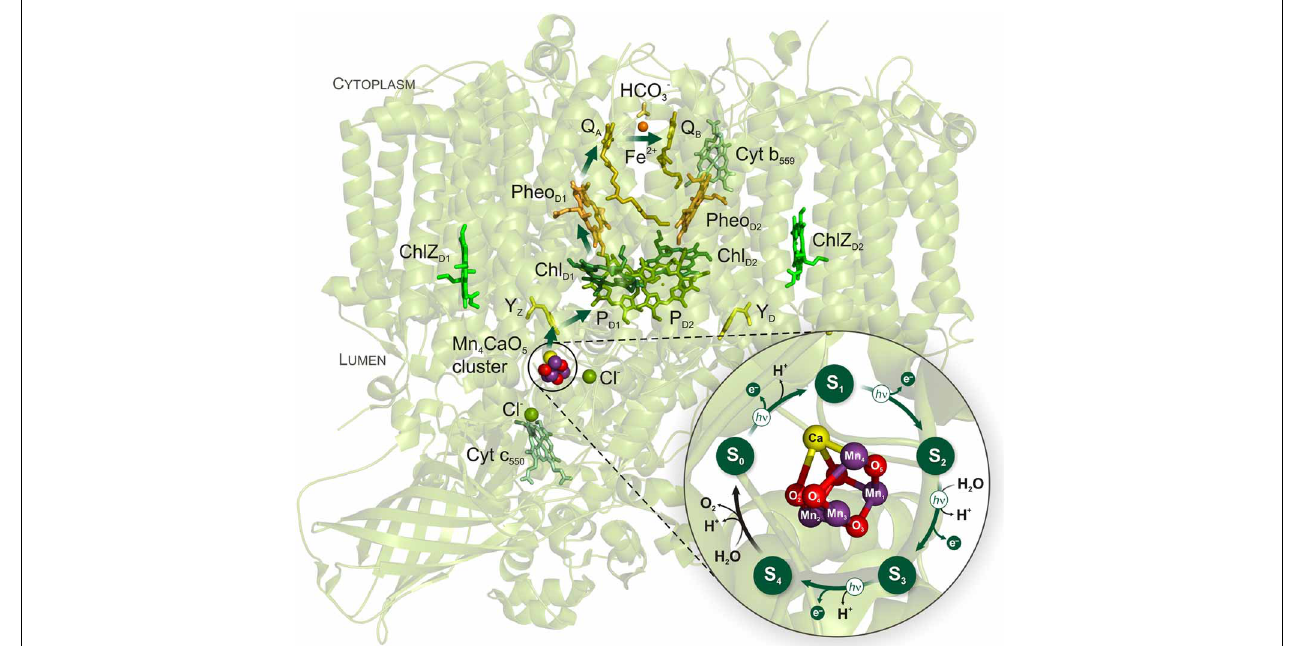
(Q B ) quinone acceptors. The phytyl tails of the Chl’s and Pheo’s, and the isoprenyl chains of the quinones have been cut for clarity. The light-induced S state transitions of the Mn 4 CaO 5 cluster are indicated by arrows with “ h ν ” labels. The PSII structure and the zoomed structural model of the Mn 4 CaO 5 cluster in the center of the Kok cycle are based on the recent PSII crystal structure at a resolution of 1.9 Å (PDB entry 3ARC; Umena et al.,